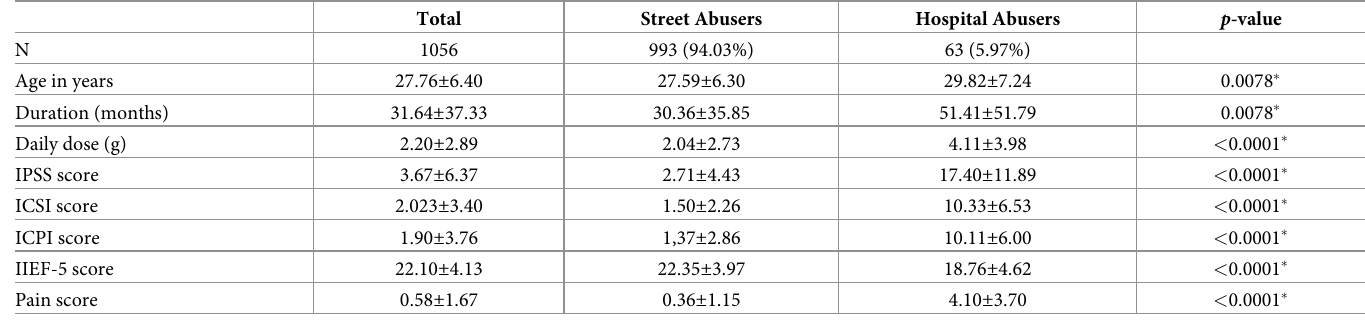
Table 1. Demographic data and results of questionnaires in street and hospital male ketamine abusers.